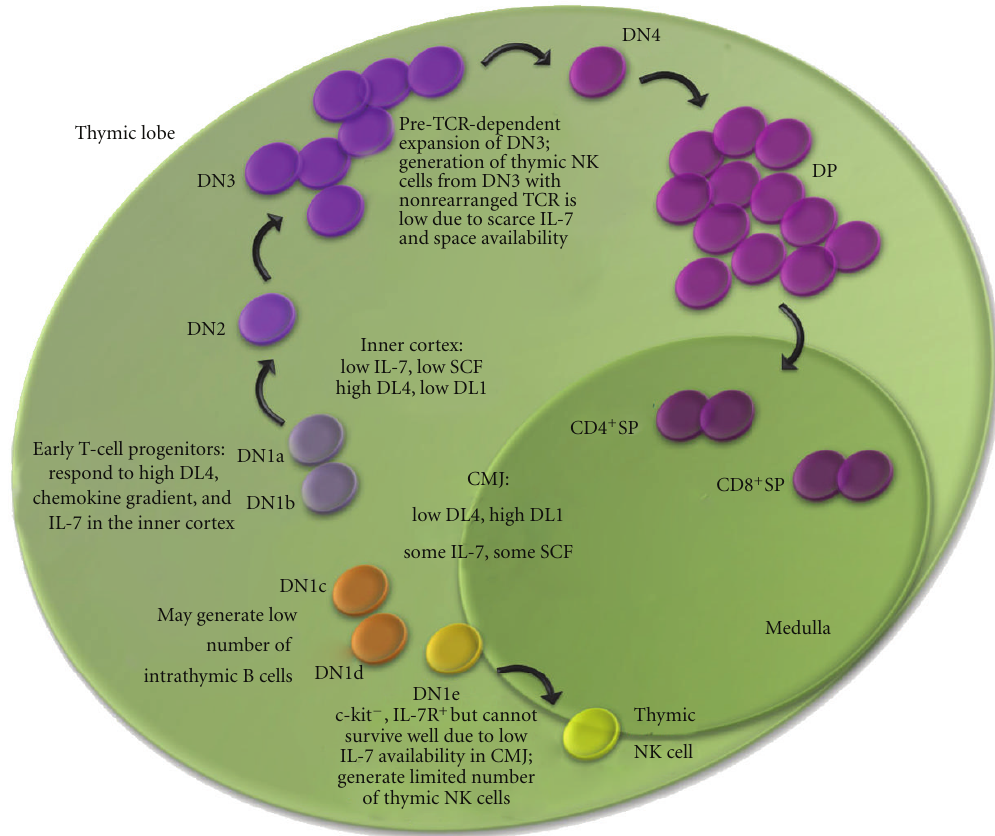
Figure 6: Development of T versus tNK cells in the thymus. DN1 cells enter thymus at the corticomedullary junction (CMJ). This area is low in DL4 but high in DL1 ligand; in addition, there is a low amount of IL-7 and SCF dispersed throughout a thymus. DN1c and DN1d cells may be progenitors to a small number of B cells generated intrathymically. DN1a and DN1b cells represent canonical early T-cell progenitors (ETPs), which migrate to the inner cortex, the area of high DL4 ligand concentration. In response to Notch signalling, ETPs turn on many of the T-lineage specific genes and develop into DN2 cells. At the DN3 stage, the cells rearrange TCR β genes and undergo β -selection, thus expanding and taking up most of the space in the outer cortex. This is disadvantageous for those DN3 cells that have not rearranged TCR β , which may give rise to the thymic NK cells. Thus, a small percentage of NK cells may be generated in a thymus, mostly from the DN1e progenitors, which are likely to remain near the CMJ region where the DL4 ligands are low and the IL-7 concentration is su ffi cient for the thymic NK cell